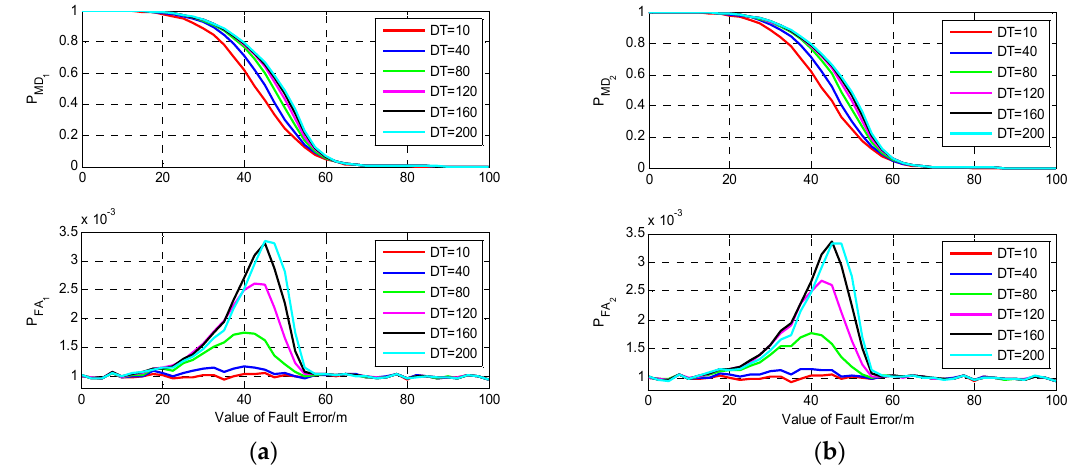
Figure 13. The results of fault detection with six visible satellites. ( a ) Fault occurs on S1; ( b ) Fault occurs on S2.